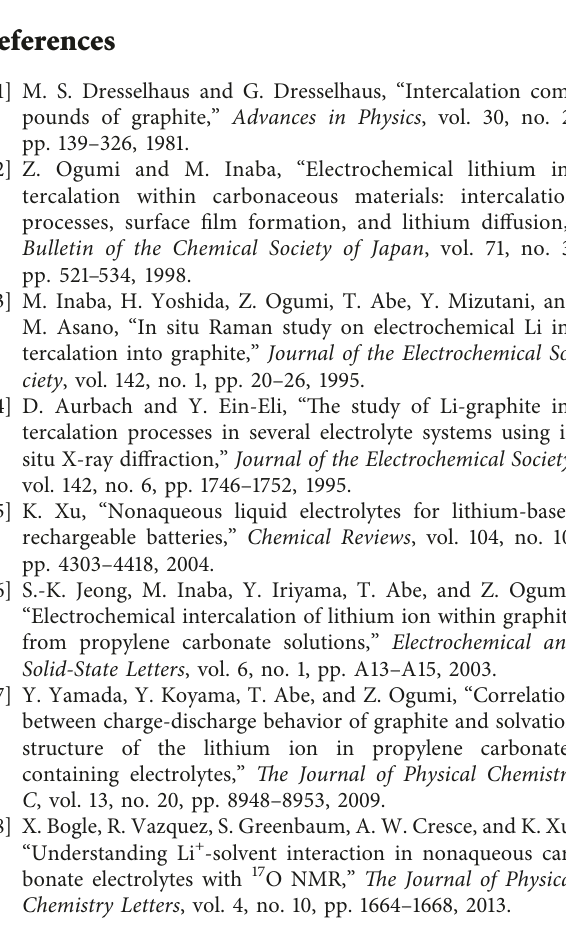
LiClO 4 /PC. The · 1 g · −